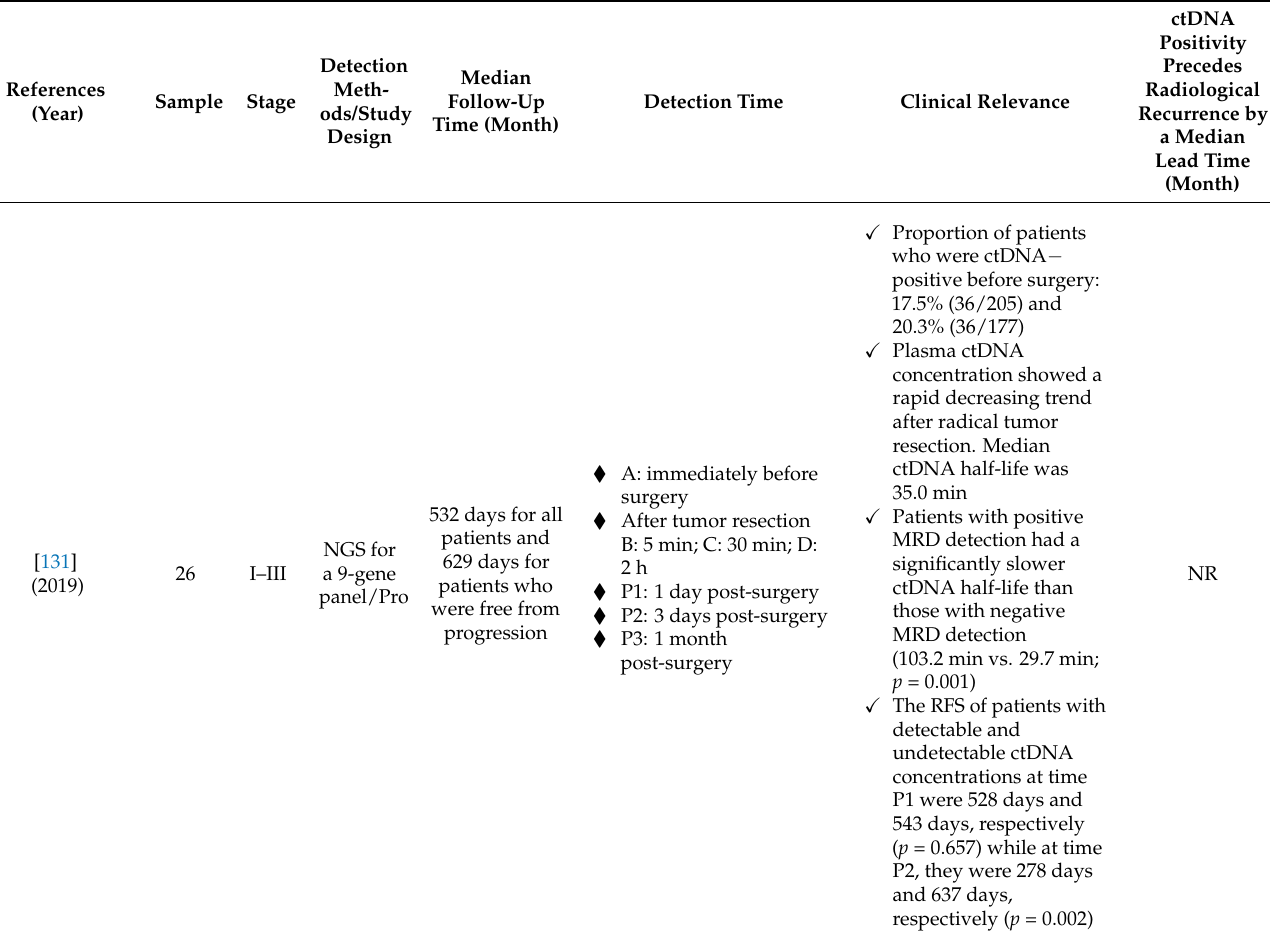
Table 3. The prognostic significance of circulating tumor DNA (ctDNA) detection at different time periods for resectable